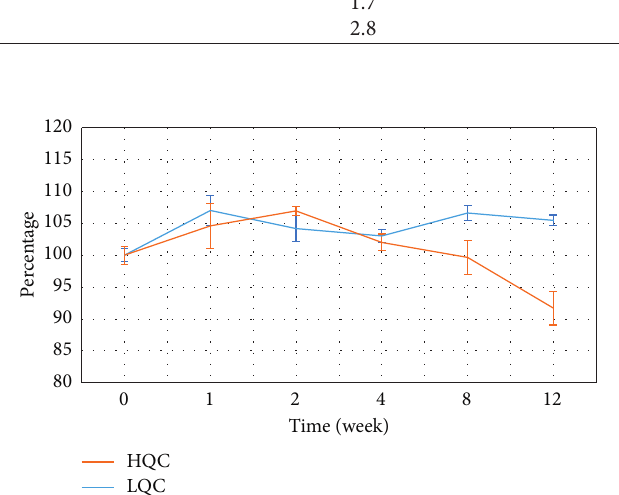
Figure 4: The stability of plasma sample spiked at two levels (LQC and HQC) within 12 weeks stored at − 18 ° C ± 2 °